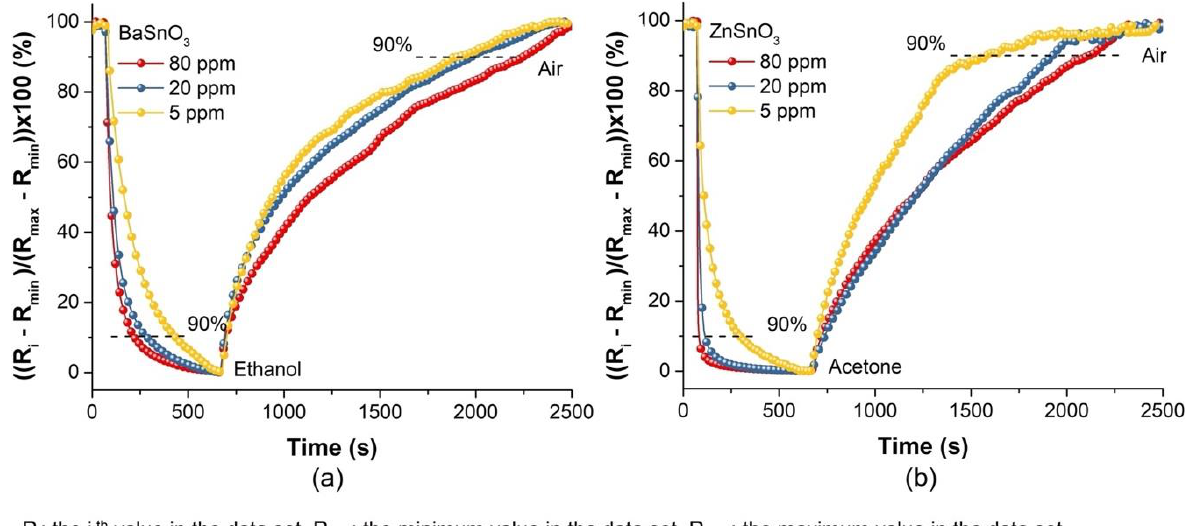
Figure 12. Response–recovery curves of the ( a ) BaSnO 3 and ( b ) ZnSnO 3 sensors exposed for 10 min to different gas concentrations of ethanol and acetone, respectively, at operating temperature of 270 °C.